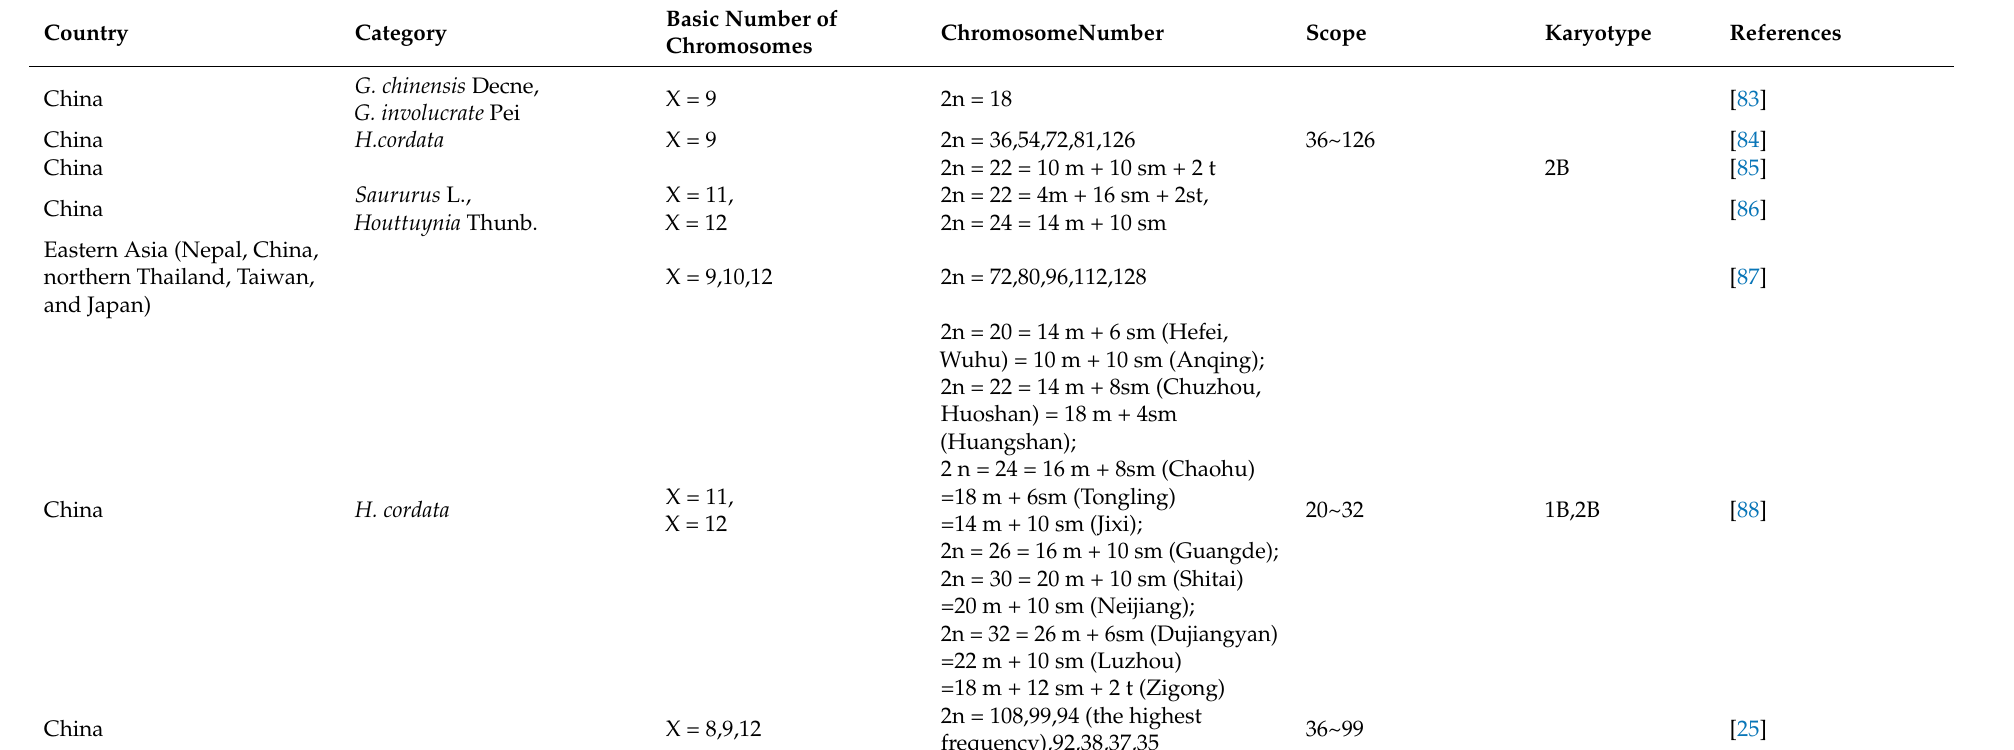
Table 1. Analysis of the karyotype of H. cordata in different